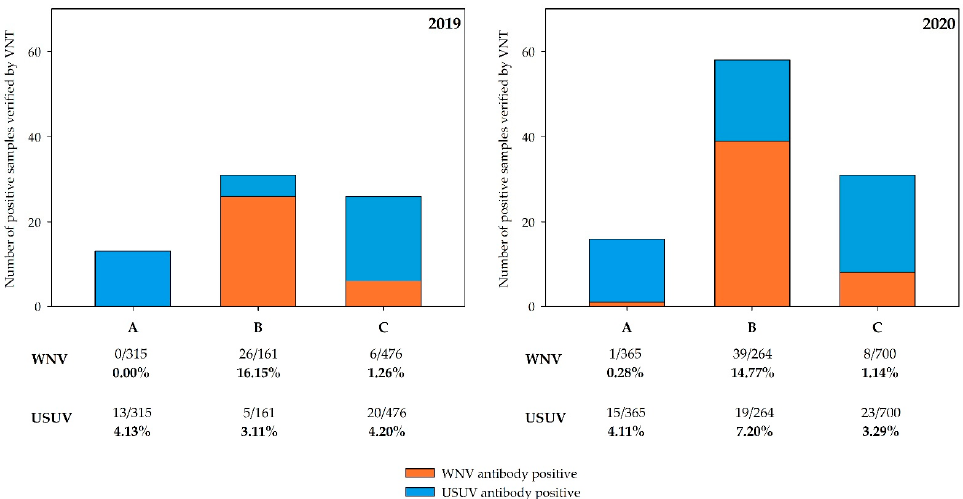
Figure 4. Number of positive bird serum samples verified by WNV and USUV VNT and the calculated seroprevalence for WNV and USUV in the three different study regions (A–C) in Germany in 2019 and 2020. The results for 2019 are shown on the left and for 2020 on the right. Serological results for 2019 include nine clinically affected free-ranging goshawks, which were published previously [56].